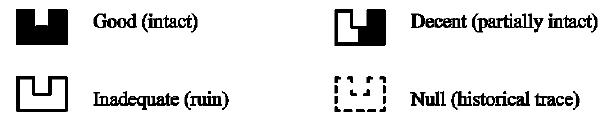
Figure 2. A proposal for the symbology regarding the state of conservation of fortified buildings